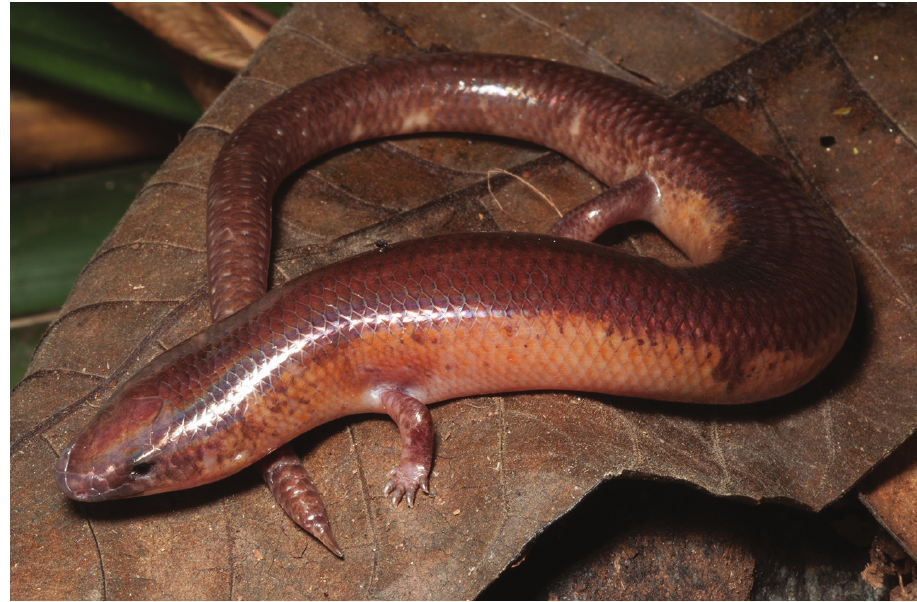
Figure 52. Brachymeles orientalis male (KU 334282) from Mt. Hilong-hilong in the Municipality of Remedios T. Romualdez, Agusan del Norte Province. Photo: